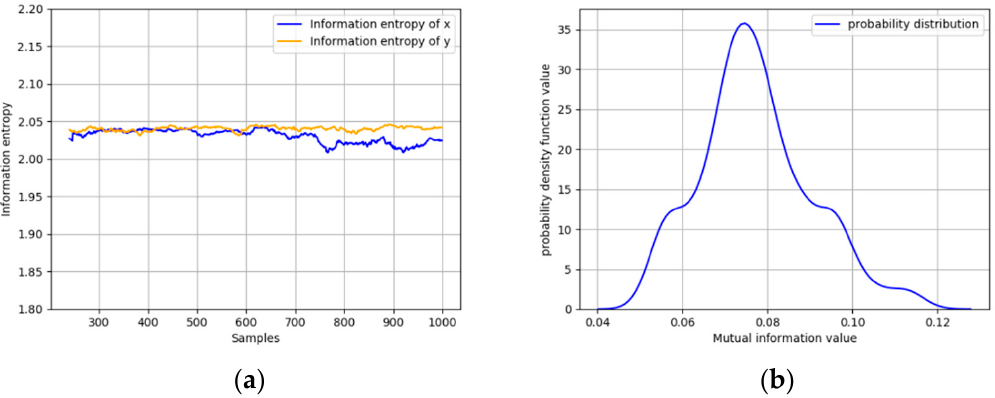
Figure 6. ( a ) IE calculated under normal conditions; ( b ) distribution of MI under normal conditions.